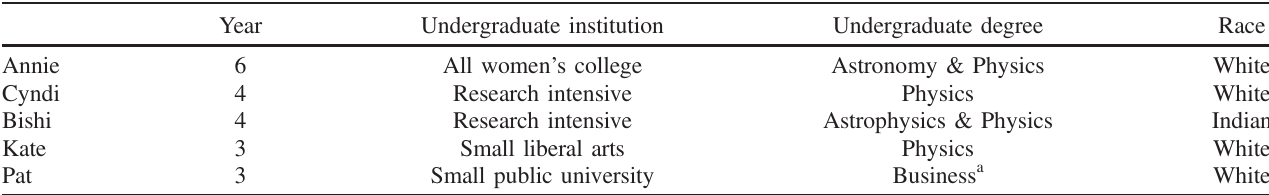
TABLE I. Participant